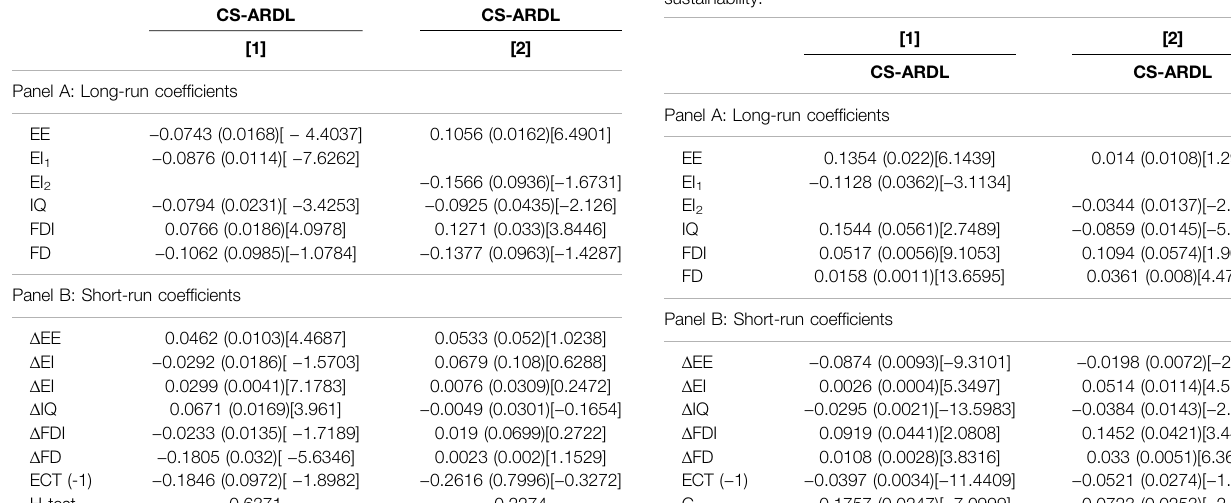
TABLE 6 | Environmental sustainability measured by CO 2